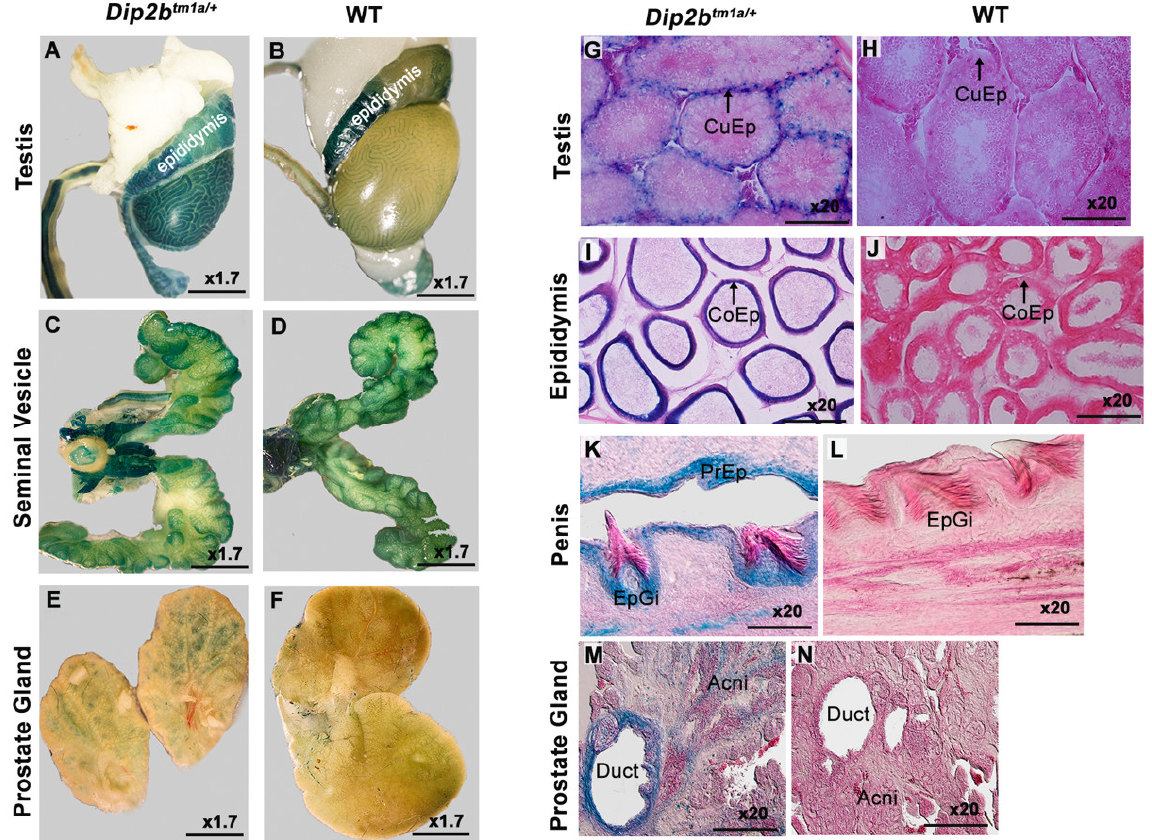
Figure 3. LacZ staining of the male reproductive system. ( A – F ) Whole-mount LacZ-stained male testis, epididymis, seminal vesicle, and prostate gland. Non-specific staining can be seen in the wild-type epididymis and Dip2b tm1a/+ seminal vesicle. ( G – N ) Frozen section of a LacZ-stained male testis, epididymis, penis, and prostate gland. CuEp, cuboidal epithelium; CoEp, columnar epithelium; PrEp, perpetual epithelium; EpGi, glans epithelium.